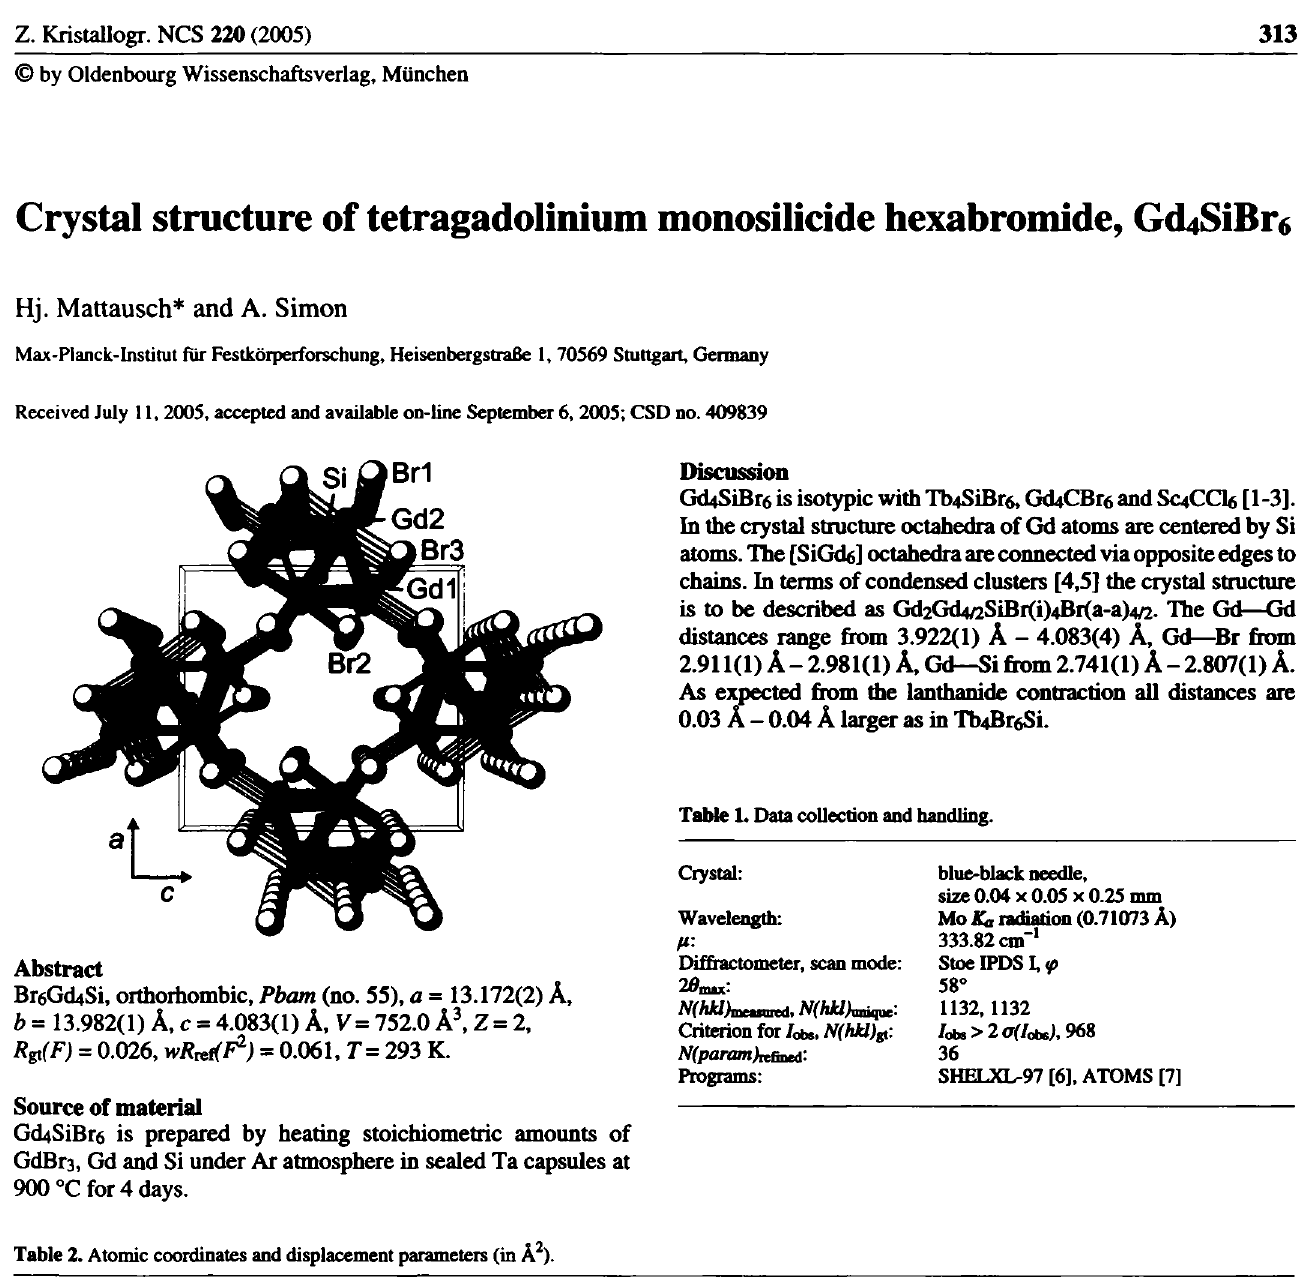
Table 2. Atomic coordinates and displacement parameters (in Ä 2